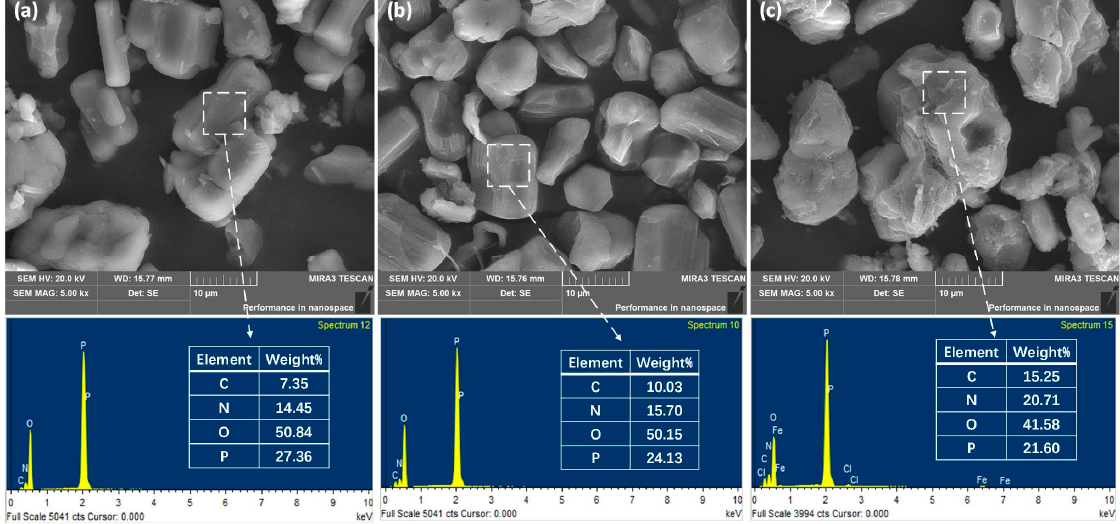
Figure 3. Microstructure of APP ( a ), MAPP ( b ) and PPy-MAPP ( c ).